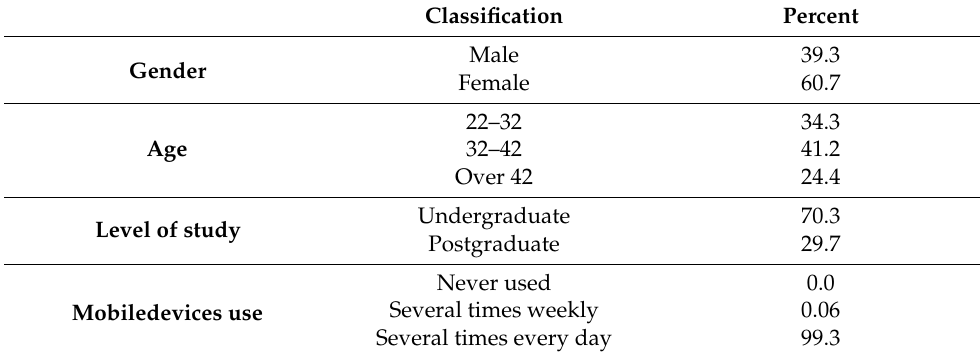
Table 1. Respondents’ demographic